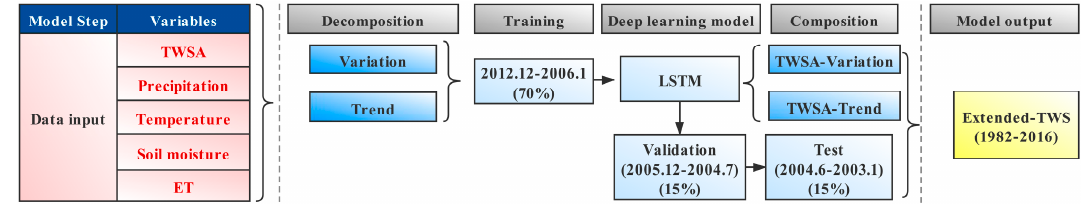
Figure 3. The workflow of reconstruction the changes of terrestrial water storage.